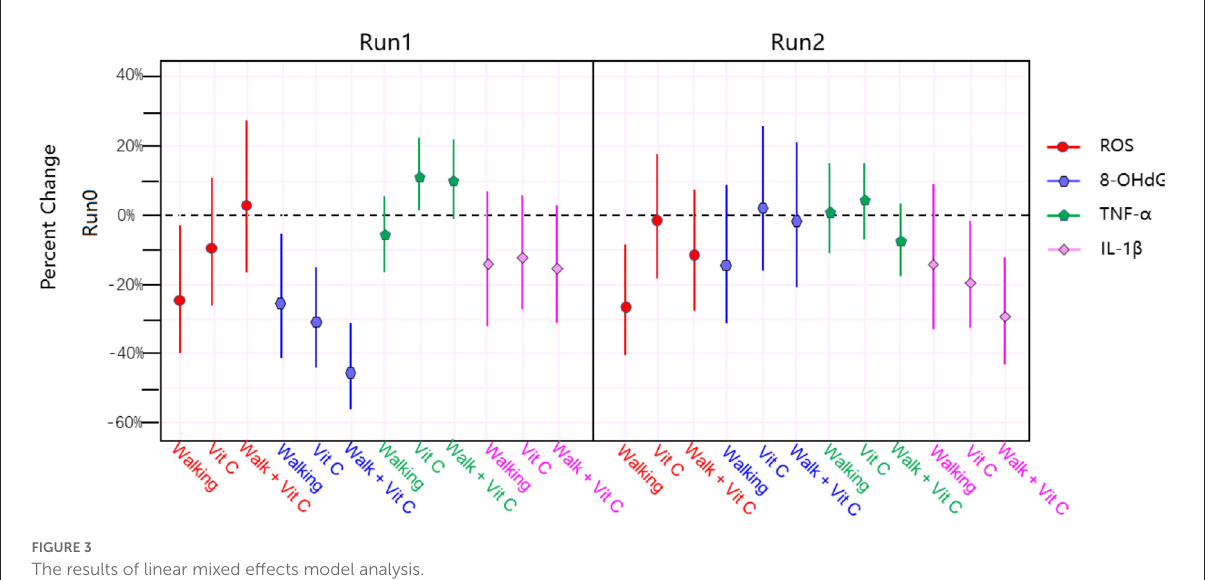
FIGURE3 The results of linear mixed effects model analysis.